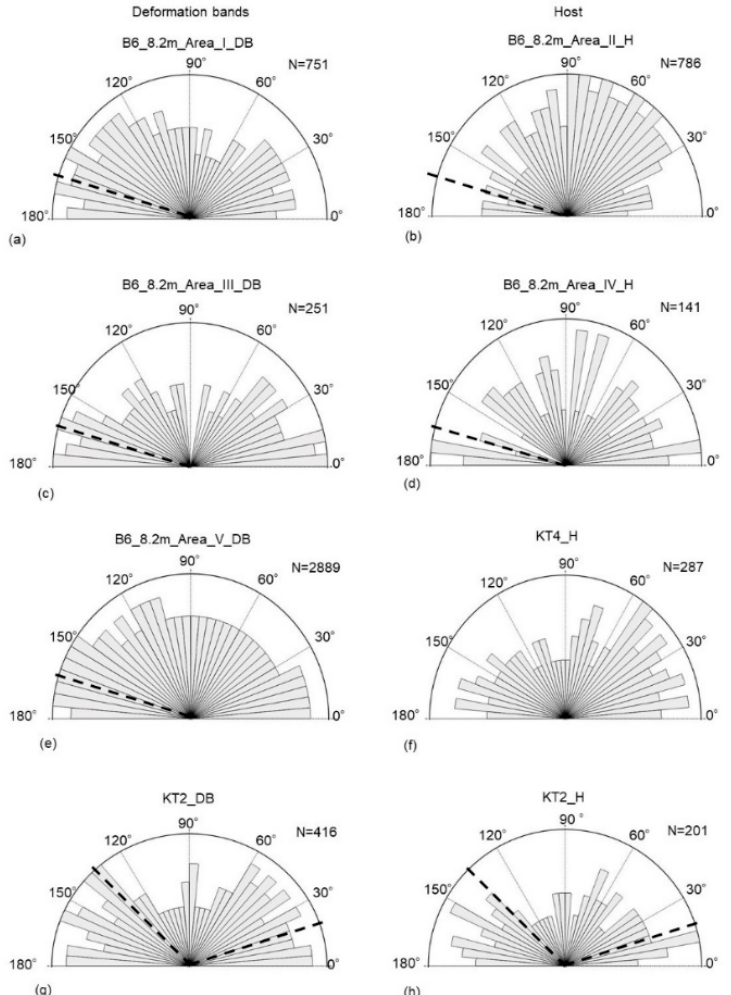
Figure 13. The orientation distribution of the long axis of the fitted ellipse to the grain shape for the ( a , c , e , g ) four deformation bands and ( b , d , f , h ) four host areas in the core and outcrop samples. Sample name is shown at the top of each diagram. Dashed lines indicate the orientation of deformation bands.